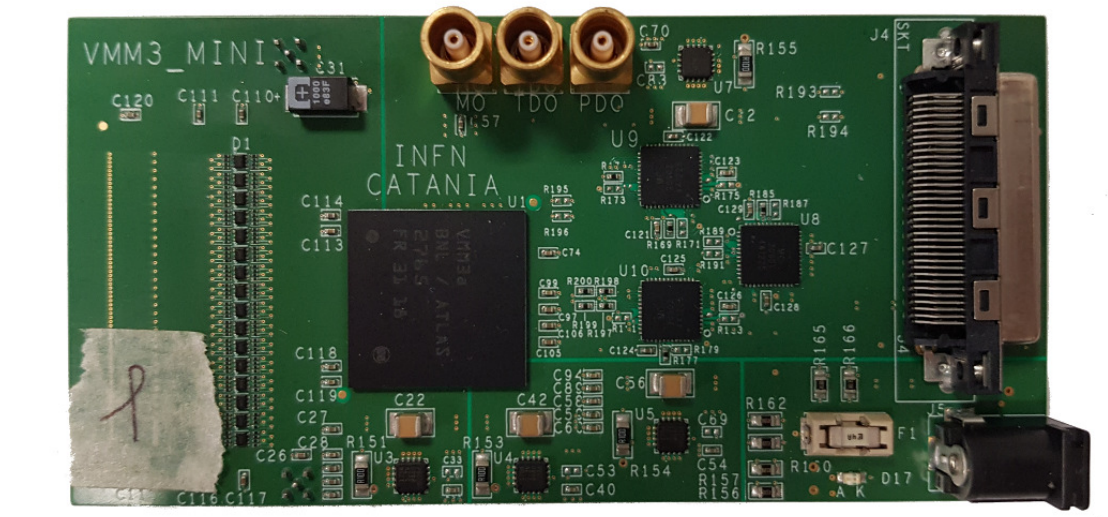
Figure 4. Front-End board with VMM3a chip